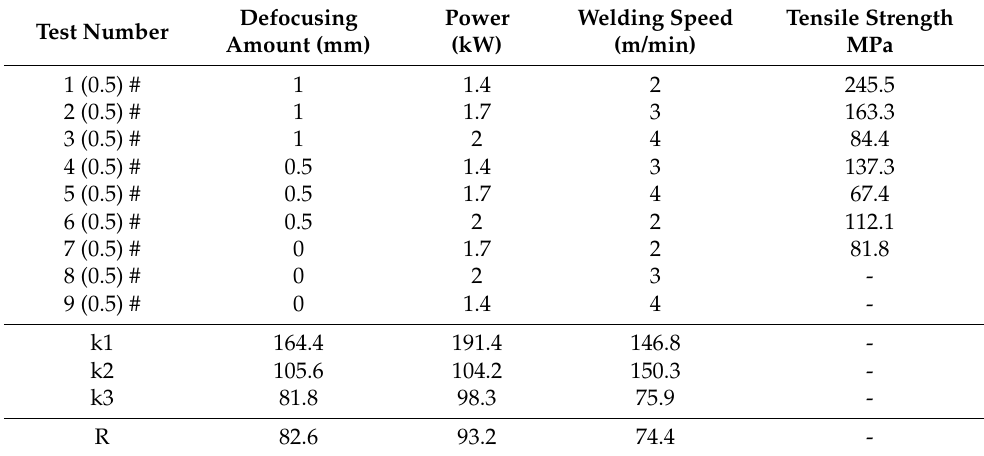
Table 6. Analysis results of the maximum tensile strengths of the Mo–Re welded joints with a thickness of 0.5 mm, obtained through a three-factor and three-level orthogonal test.